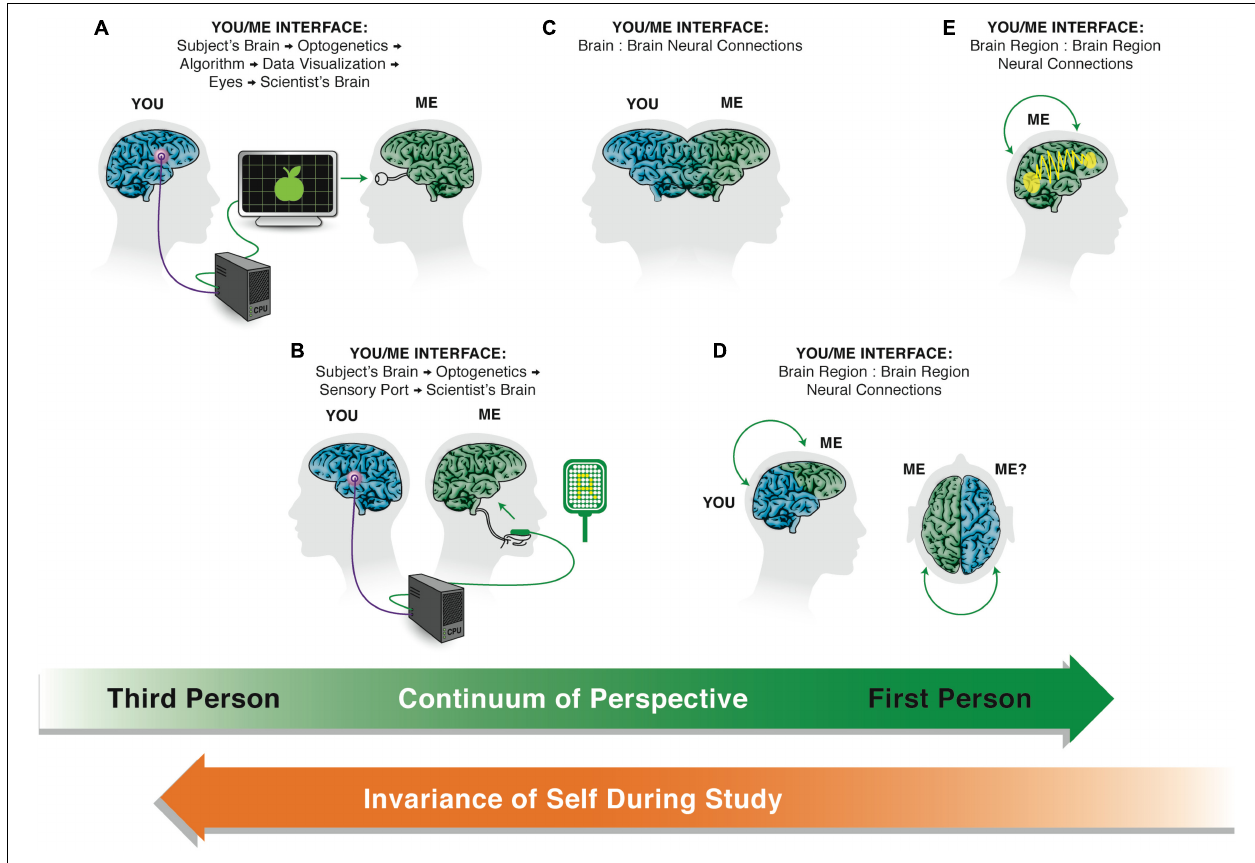
FIGURE 11 | Technology reveals gradualism in Descartes’ cut. The apparent fundamental gulf between first person perspective (what is it like to be a specific Self) and third person perspective (external scientific study of that cognitive system) can be seen to also be a gradual continuum, when modern technology is used to expand heterophenomenology (Dennett, 1991). On the left side of the continuum (A) is a traditional 3-rd person scenario of an agent studying another by measuring its physical states: cognitive states can be inferred but not directly experienced (correlates of consciousness), giving rise to the problem of other minds, and a firm distinction between “you” and “me.” However, sensory substitution and augmentation technology now enables the plugging of various peripherals and sensors directly into the nervous system of subjects, and thus it is possible to connect the output of electrophysiology equipment directly into the subject’s brain (B) . For example, if the output of a multielectrode array recording neural activity of subject #1 is connected directly to the brainport device (Danilov and Tyler, 2005) of subject #2 (e.g., a scientist), this allows #1’s mental states to more directly provide input into #2’s sensory stream. This can be made even more direct by fusing portions of two brains directly, during embryogenesis, illustrating that the strength of boundaries between “you” and “me” is variable; this configuration may seem far-fetched, but note that it can be readily produced today in animal model systems, and the only barrier to such configurations is ethical, not empirical or logical (C) . It’s critical to note that these fusion experiments are not just aberrant corner cases, because all brains are already fusions of neural modules. Single subjects’ brains consist of two hemispheres which must communicate to give rise to a coherent, centralized perception of “me” despite being made of communicating parts, and can be dissociated by commissurotomy (D) . Indeed, beyond the two hemispheres, any brain is a collective of smaller active subunits (E) that must all communicate as a collection of cells (each neuron is part of the neighboring neural cell’s “external environment”). This gradient of diverse connections, whether electronic or biological, between and within brains and brain components can be reproduced or expanded upon to whatever degree necessary by biological or technological fusion among subjects. The technological aspect of TAME is that we must develop frameworks that deal not only with standard embodiments of mind as happened to be produced by the path evolution took through life on Earth, but all logically and empirically possible configurations that could evolve, be designed, or both, whether on Earth or in exobiological contexts. The hierarchical, not monadic, structure of cognitive substrates means that the relationship between the parts of one Self and that between a Self and an object of external study is a continuum, not a discrete natural kind. This suggests a key way that actual Consciousness can be studied—by becoming inherently a participant in the experiment, so as to study it from a first-person perspective. Importantly however, what happens when one fuses cognitive systems with their subject of study is that a new Self appears (a composite cognitive system), showing that the Self can remain invariant while pursuing scientific study of functional cognition and behavior (the left of the spectrum), but essentially must change in order to gain first-hand knowledge of consciousness in other cognitive systems. Images are courtesy of Jeremy Guay of Peregrine